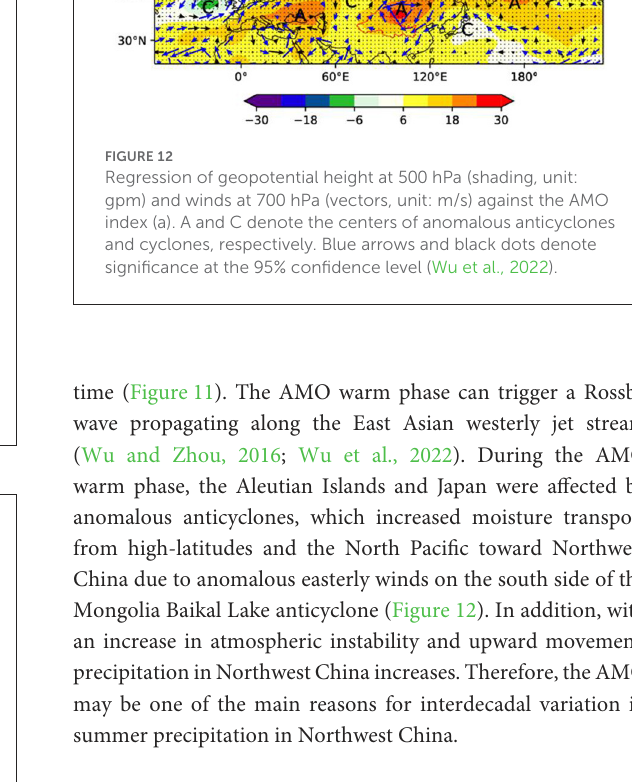
FIGURE11 Time series of AMO indices (the black line is the normalized summer precipitation index).